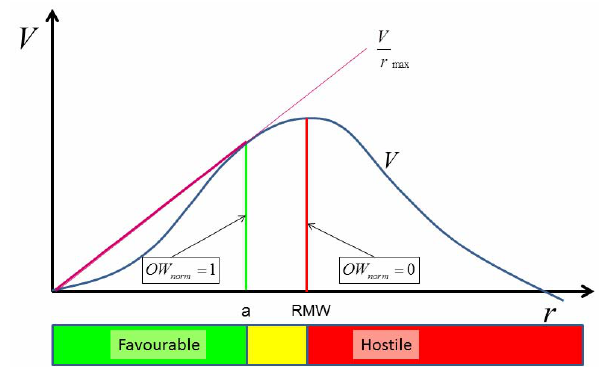
V , which is defined 5 r